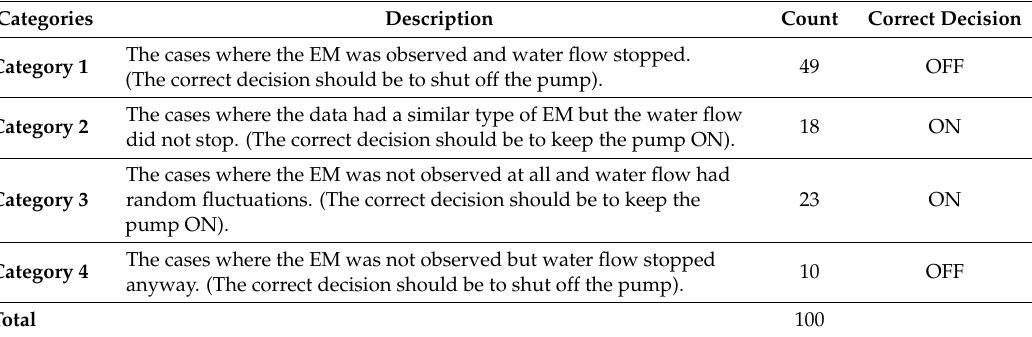
Table 4. Description and details of categories in cases of flowmeter